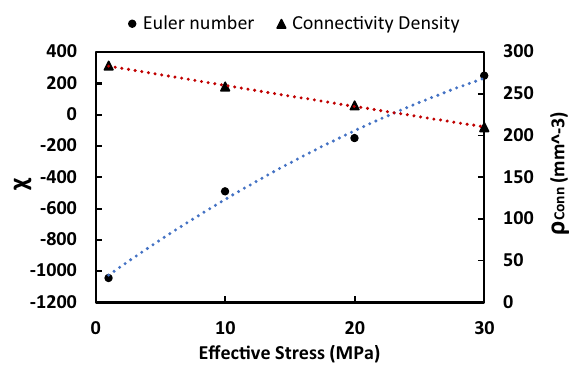
Figure 5. This figure shows stress-dependent changes in Euler number and connectivity density (mm −3 ) of the cube, which indicate the transition of the porous media from a well-connected ( χ < 0 ) to a poorly-connected ( χ > 0 ) pore-space with an increase in effective stress from 0 to 30